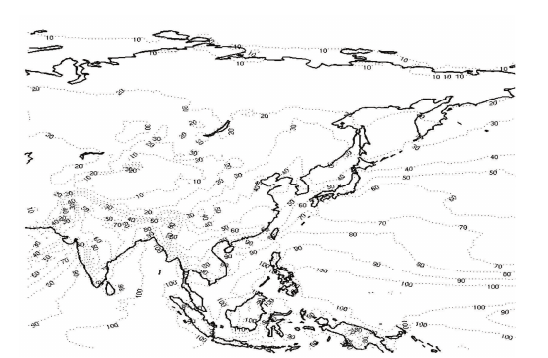
Figure 3: Rain rate (mm/h) exceeded for 0.01% of the average year, obtained using the ITU-R P.837-5.